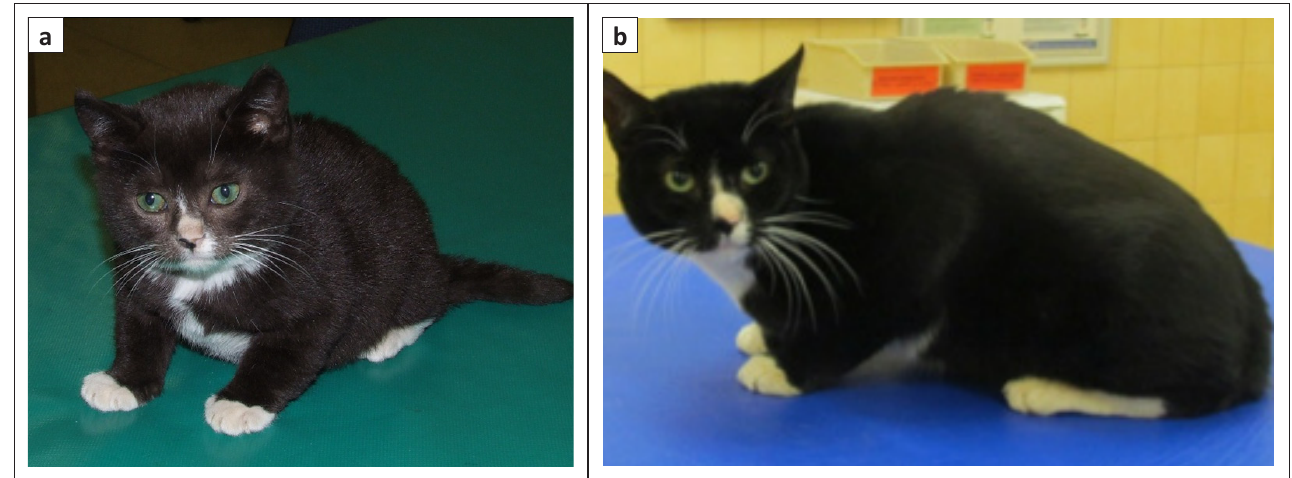
FIGURE 1: (a) A 3-month-old kitten with disproportionate dwarfism (note the short and stubby limbs and the broad head and flattened facial features) and (b) same cat at the age of 41